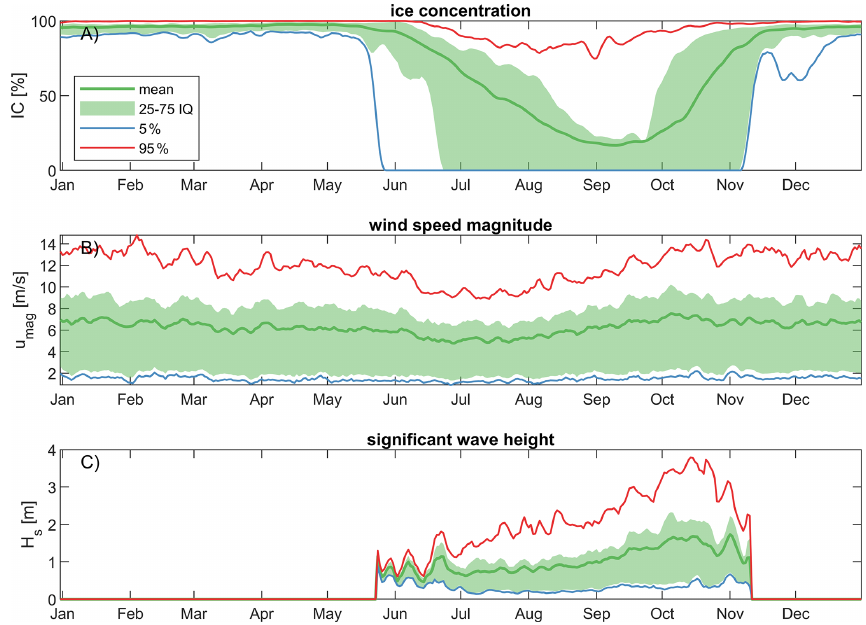
Figure 3. Ice concentrations (a) , wind speed magnitude (b) , and significant wave height (c) at the single ERA5 output point of 72 ◦ N, 147 ◦ W (see Fig. 1 for the location) averaged daily over the time period 1979–2019. Each subplot shows the mean, 5%, 25%, 75%, and 95% exceedance probability. The interquartile range (IQ) is the area shaded green between the 25th and 75th percentiles. Table 1. Overview of wave observations used for calibration and validation purposes in this paper. The name of each observation is a combination of the calendar year of deployment and a letter. Longitude and latitude are coordinates in degrees (WGS84). Depth is in meters relative to mean sea level. The start and end dates (mm-dd) of deployment are indicated. The comment provides more information including which measurement was used for calibration and validation for sea ice coefficients and friction coefficients and